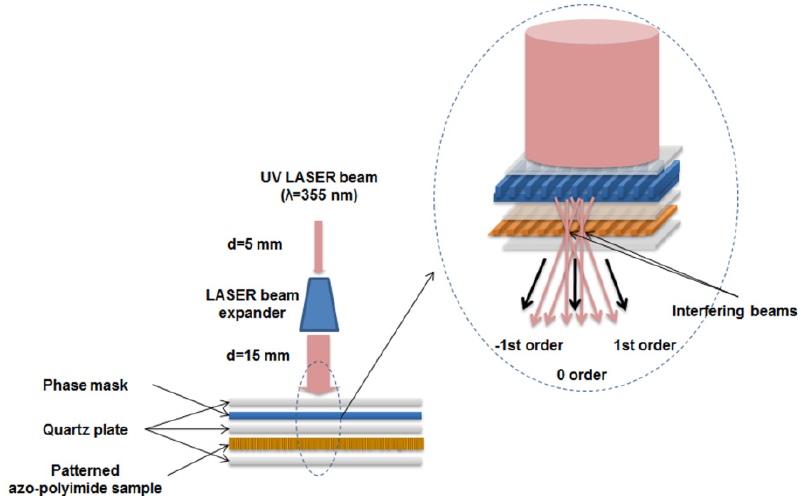
Figure 2. Pulsed laser irradiation through a phase mask setting, with a detail on the formation of interference image on the azo-naphthalene-based polyimide surface.